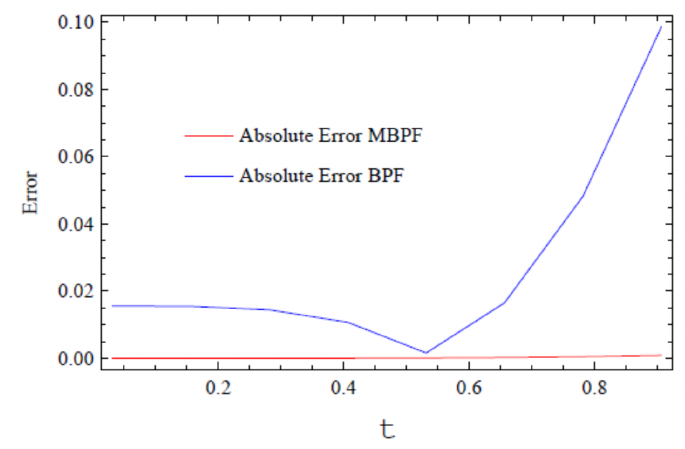
Figure 10. The absolute error of IBPFs and BPFs expansions comparison at the midpoints of the intervals of IBPFs.